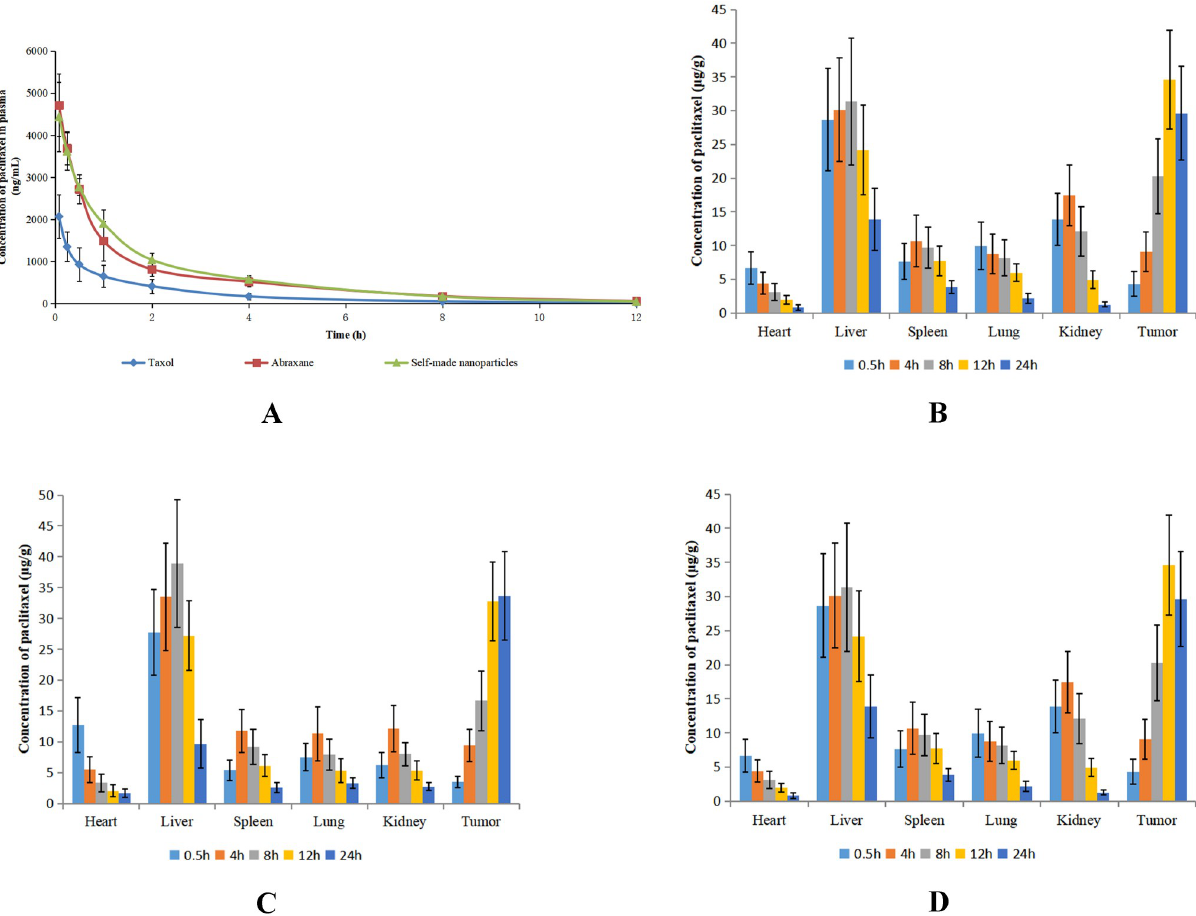
Fig 8. Dynamic and biodistribution of Taxol, Abraxane, and self-made nanoparticles. (A) Plasma concentration-time curves of paclitaxel in rats receiving a single dose of Taxol, Abraxane, or self-made nanoparticles at a paclitaxel dose of 7mg/kg. (B) Biodistribution of paclitaxel in tumor-bearing mice after intravenous administration of Taxol. (C) Biodistribution of paclitaxel in tumor-bearing mice after intravenous administration of Abraxane. (D) Biodistribution of paclitaxel in tumor-bearing mice after intravenous administration of self-made nanoparticles. The data are shown as means ± SD (n = 5).